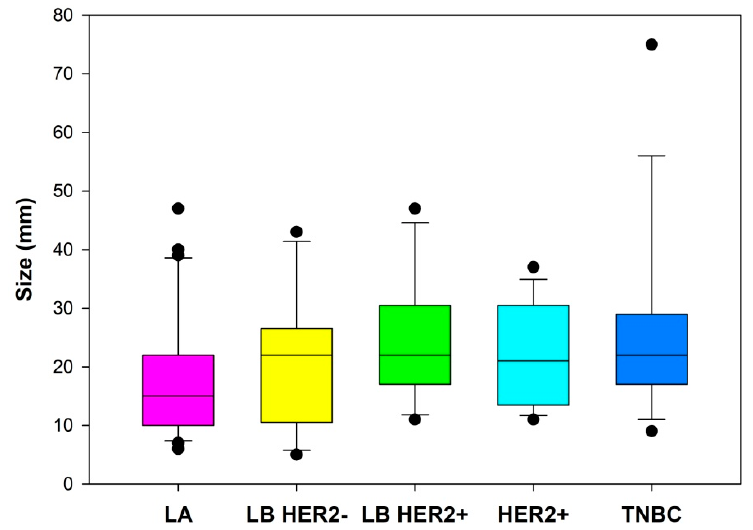
Figure 4. Size of tumors of specific breast cancer subtypes. LA = luminal A; LB HER2 − = luminal B without HER2 overexpression; LB HER2+ = luminal B with HER2 overexpression; HER2+, = human epidermal growth factor receptor 2 positive; TNBC = triple negative breast cancer. Horizontal lines represent median (black), the bottom and the top of the boxes represent the upper and the lower quartile, the whiskers represent 10th and 90th percentile, while the solid circles represent the individual data points.